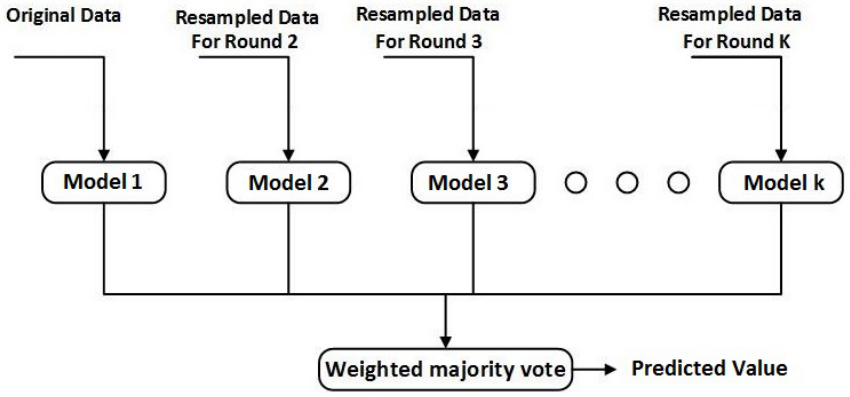
Figure 3. The framework of